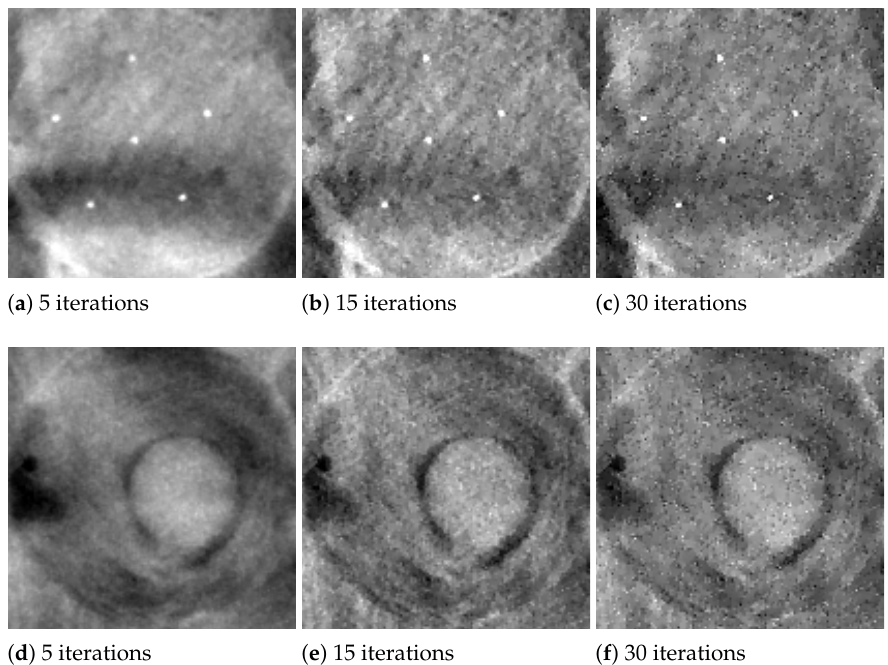
Figure 6. SGP results on BR3D phantom. ( a – c ) Reconstructions of MC cluster number 5 obtained after 5, 15 and 30 iterations. ( d – f ) Reconstructions of mass number 2 obtained after 5, 15 and 30